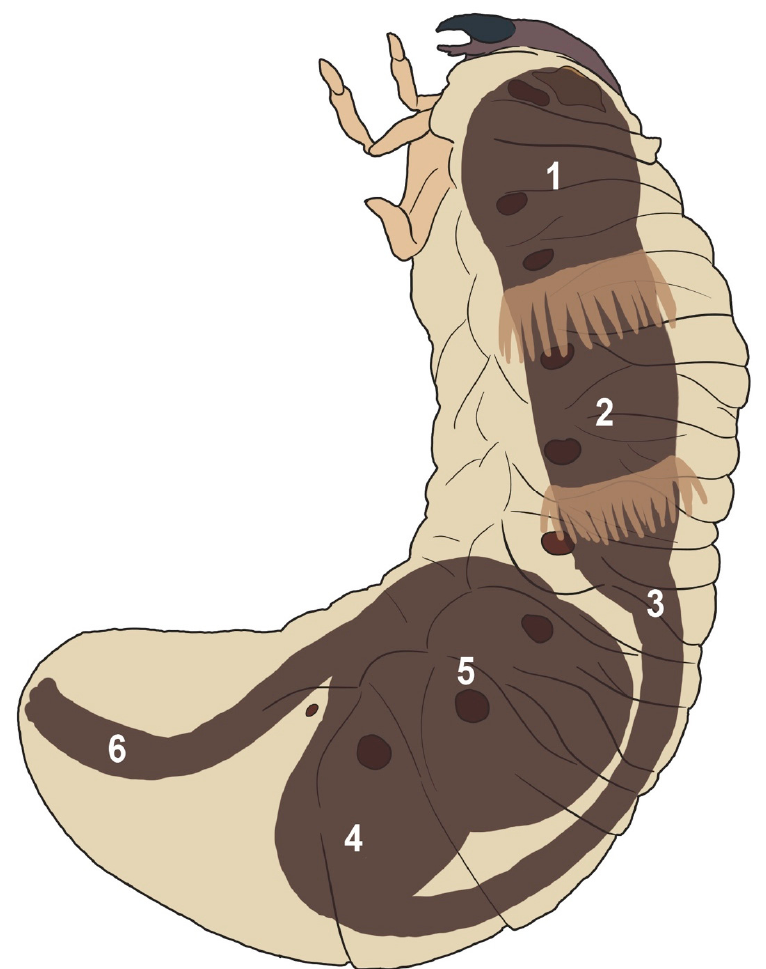
Figure 1. Diagram of the digestive tract of a larval Oryctes rhinoceros . The numbering corresponds